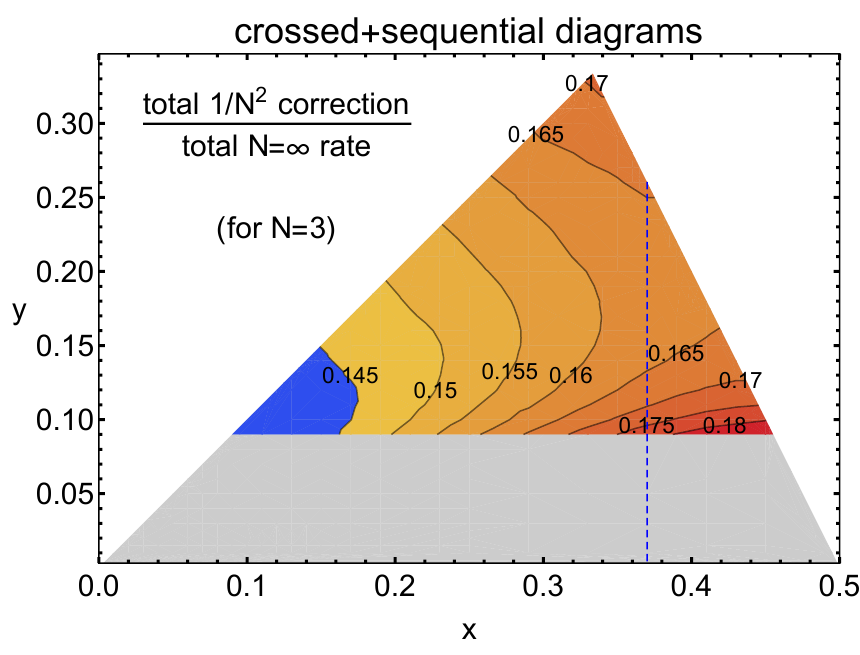
Figure 17 . Like figures 15 and 16 except now for the total g → ggg rate. The behavior for y<0.1 (the gray shaded region) is discussed in the main